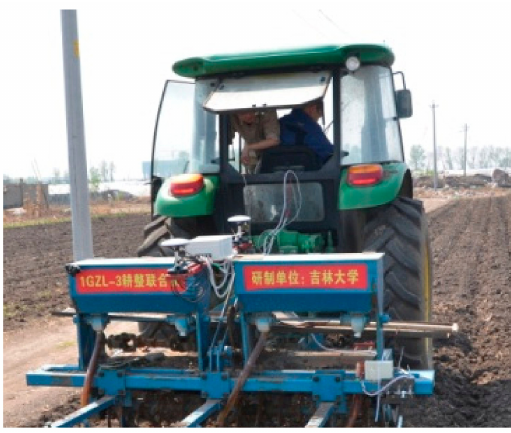
Figure 14. Field dynamic experiments.